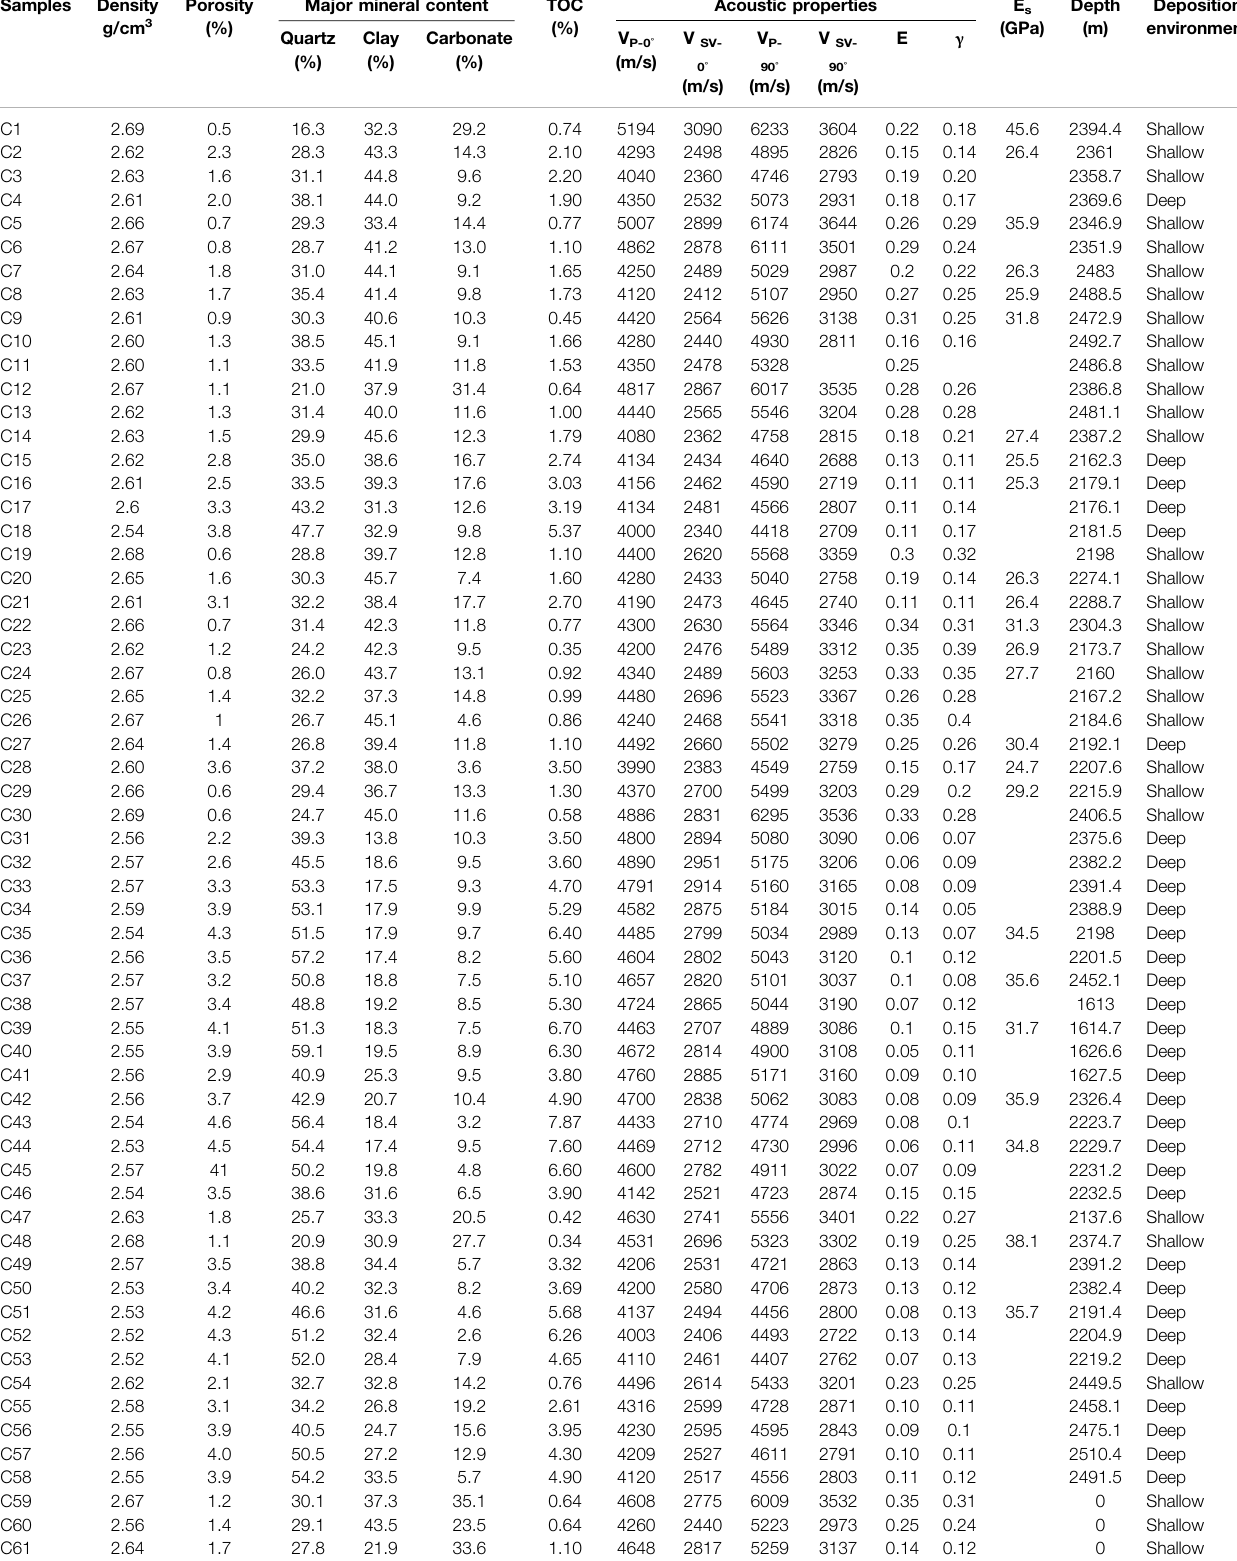
TABLE 1 | Database of mineral content and rock physical properties of sales sample at 30 MPa con fi ning pressure. Samples Density g/cm